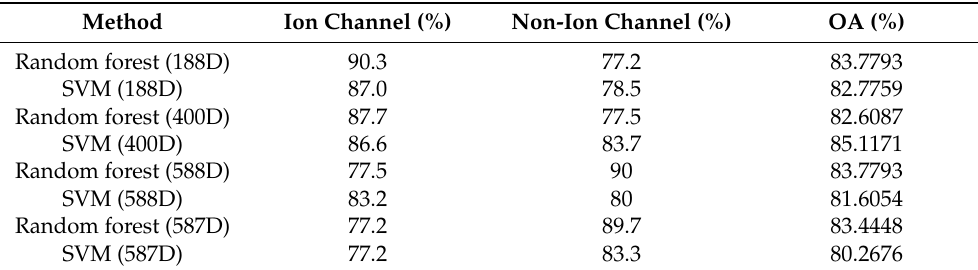
Table 3. Prediction results of the ion channels and the non-ion